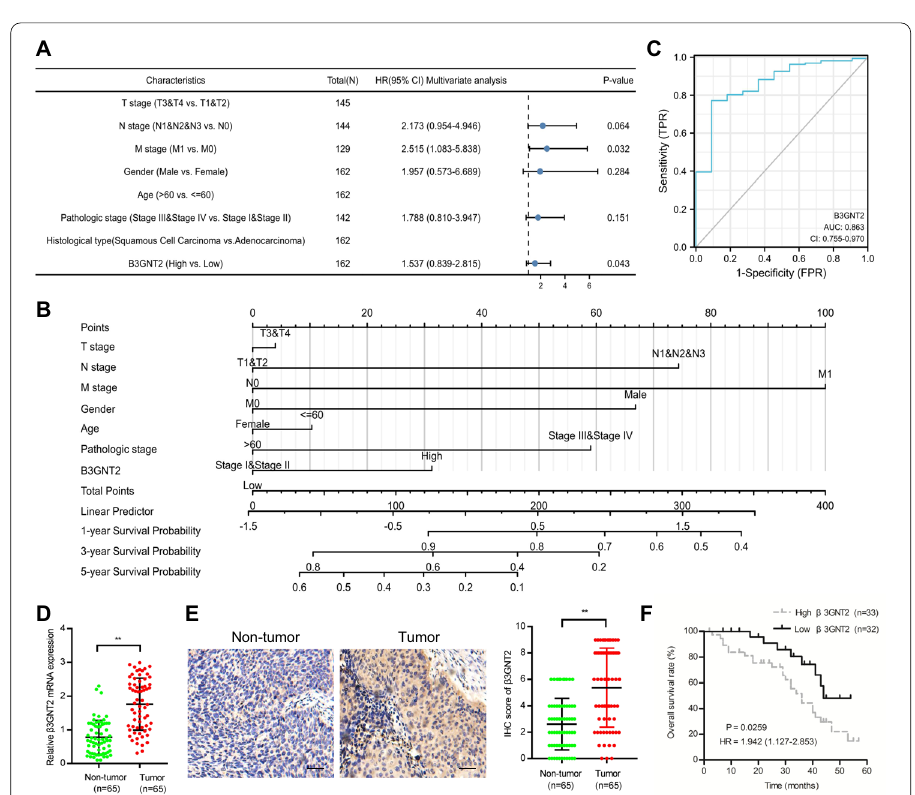
Fig. 2 High expression of β3GNT2 in ESCA predicts poor prognosis. A Forest plot based on multivariate Cox analysis. B A nomogram predicting 1-, 3-, 5-year survival rate. C The diagnostic value analysis of β3GNT2 by ROC curve. D Analysis of β3GNT2 mRNA expression by qPCR. E Analysis of β3GNT2 protein expression by IHC (bar value 100 μm). F Kaplan–Meier analysis of overall survival according to β3GNT2 expression. Data are = expressed as mean SD. **P < ±